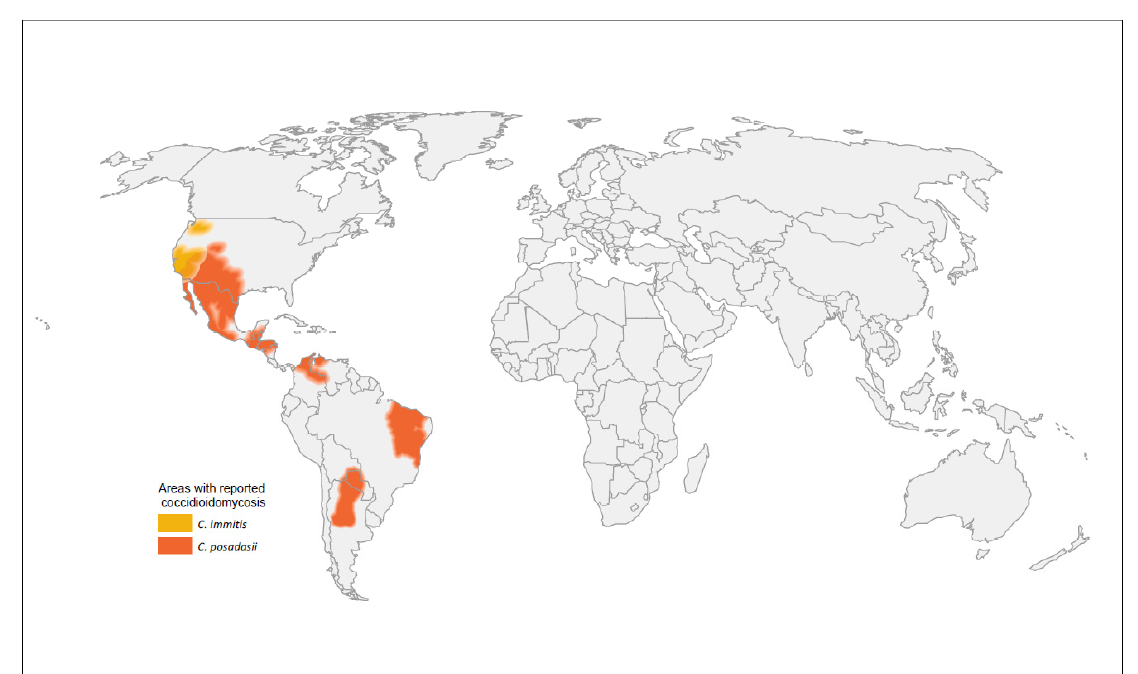
Figure 1. Global geographic distribution of the Coccidioides species.